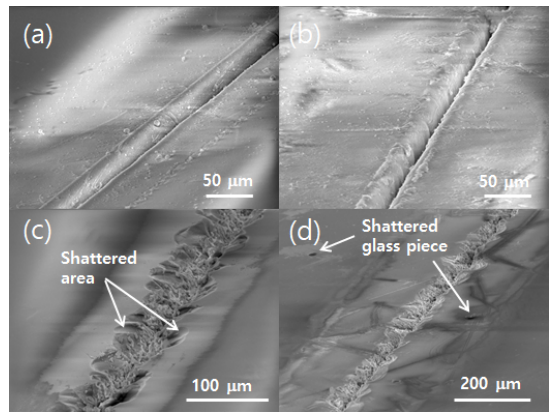
Figure 7. SEM images of the glass surface damaged by single laser scan. Laser power: ( a , c ) 2.28 W and ( b , d ) 2.8 W. Scan speed: ( a , b ) 15 mm/s and ( c , d ) 35 mm/s.